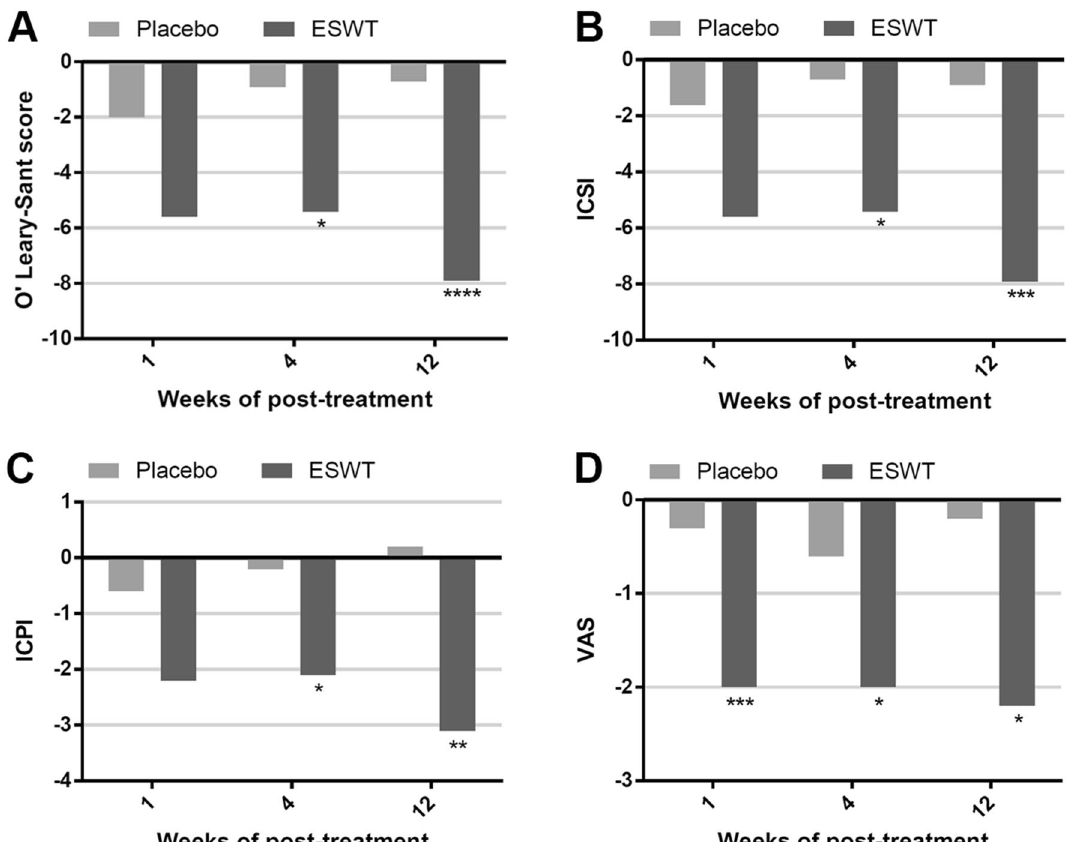
Figure 2. Outcome measures of ESWT group versus placebo group at baseline, week 1, week 4 and week 12 in OSS ( A ), ICSI ( B ), ICPI ( C ) and VAS ( D ). ESWT extracorporeal shock wave therapy, ICPI interstitial cystitis problem indices, ICSI interstitial cystitis symptom indices, OSS O’Leary ‐ Sant symptom scores, VAS visual analog scale. * P < 0.05, ** P < 0.01, *** P < 0.005, **** P <